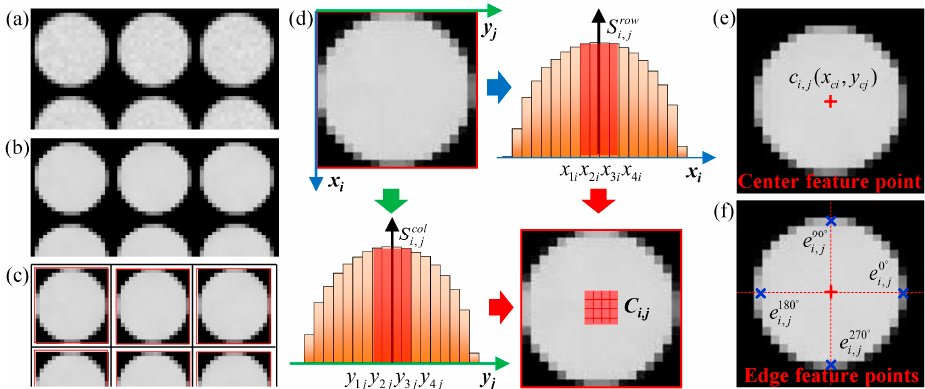
Figure 3. Location and extraction of subpixel feature points: ( a ) White raw image; ( b ) Bilateral-filtered image; ( c ) Microlens subimage region segments; ( d ) Coarse center region location; ( e ) Extracted center feature point; and ( f ) Extracted edge feature